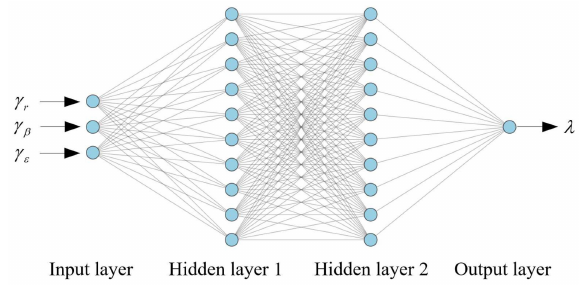
Figure 4. The structure of actor network. Table 1. Neural network settings.